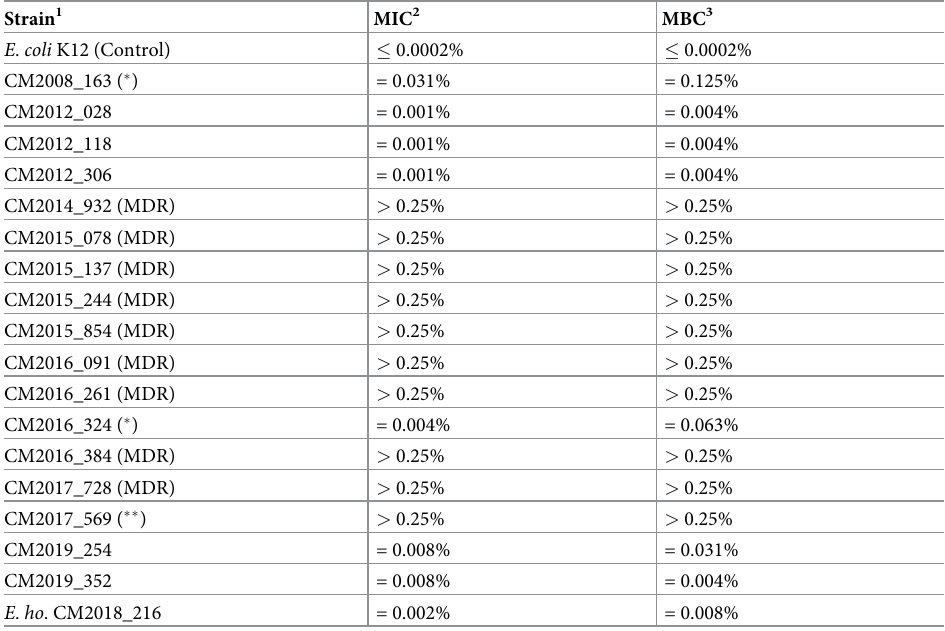
Table 4. Chlorhexidine Minimum Inhibitory Concentrations and Minimum Bactericidal Concentrations for Ser- ratia spp. isolates, showing a higher resistance to this biocide within the MDR strains compared to the other strains. Strain 1 MIC 2 MBC 3 E . coli K12